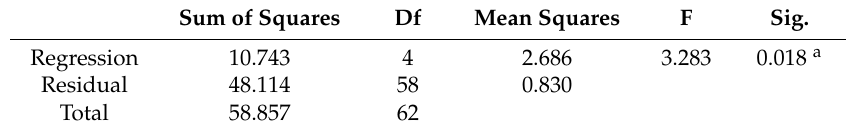
Table 9. The regression analysis of the factors on the originality evaluation by urban designers. Sum of Squares Df Mean Squares F Sig. Regression 10.743 4 2.686 3.283 0.018 a Residual 48.114 58 0.830